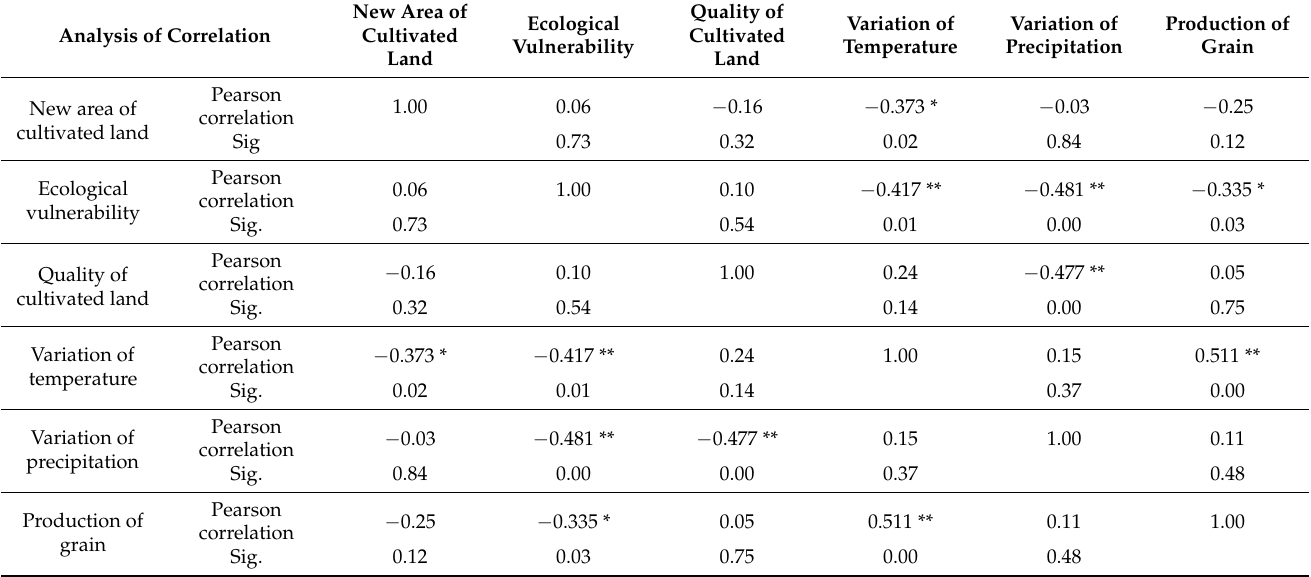
Table 7. The relationship between landscape indicators and variables in rural